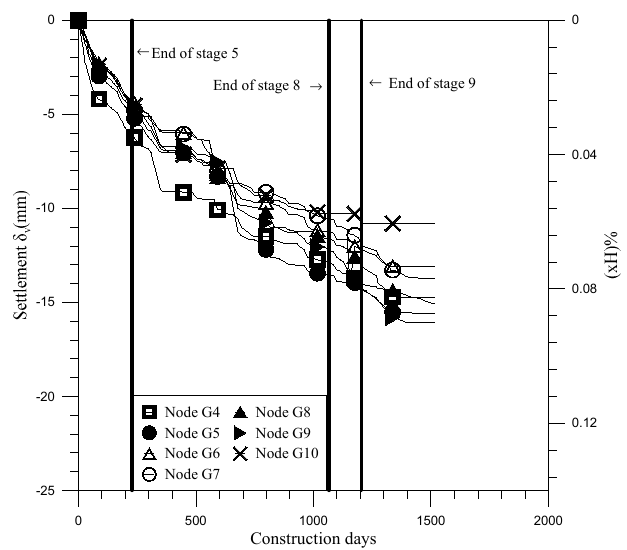
Figure 10. Ground settlement of points 4–10.